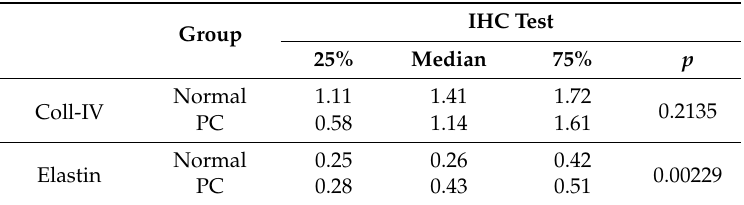
Figure 2. Immunostaining for Coll-IV and elastin in canine prostatic tissue. ( a ): Coll-IV immunostaining in the basal membrane of canine PC with cribiforme pattern (case No. 15). ( b ): Absence of Coll-IV immunostaining in canine PC with solid pattern (case No. 12). ( c ): Elastin fibers around the prostatic acini of normal samples (case No. 5). ( d ): High amount of elastin fibers around the urethra (case No. 5). Table 3. Median, 25% percentile and 75% percentile values of area percentage staining for Coll-IV and elastin in the normal prostate and canine PC samples.